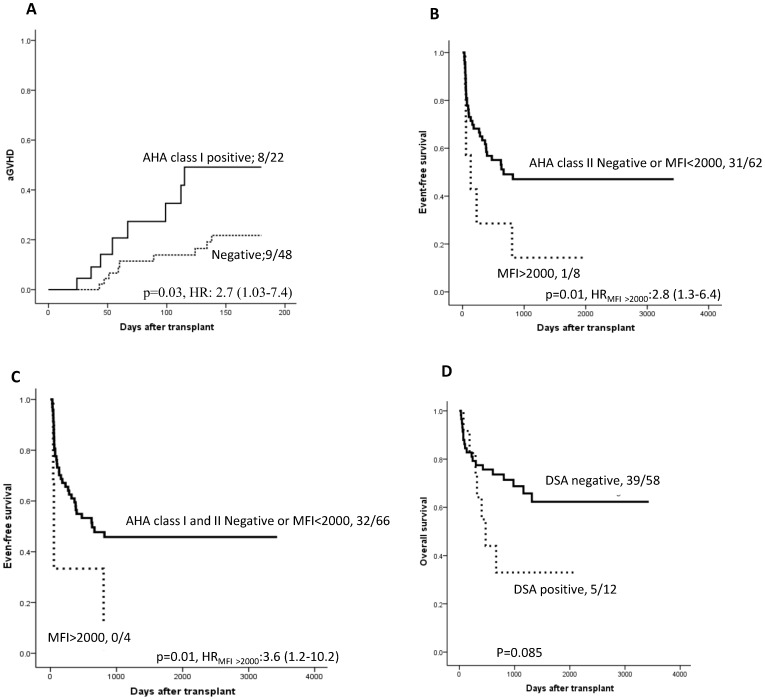
Cumulative incidence of acute GVHD (grade 1–4), event-free survival and overal survival.The number of patients with aGVHD occurrence or with no events or survived/total number of patients in each group, hazards ratios with 95% confidence interval is presented on the plot. A) Patients positive for class I AHA had higher incidence of aGVHD (36.4%) compared to those negative for class I AHA (18.7%). B) Patients positive for class II AHA with mean florescence intensity (MFI) above 2000 had lower event free survival (12.5%) compared to those negative or positive with MFI less than 2000 (50%). C) Patients detected for both class I and II AHA had lower EFS (0%) compared to those negative or positive with MFI below 2000 (48.5%). D) Patients with DSA against the HLA mismatch of the cord blood had a trend of lower overall survival (41.6%) compared to patients without DSA (67.3%).